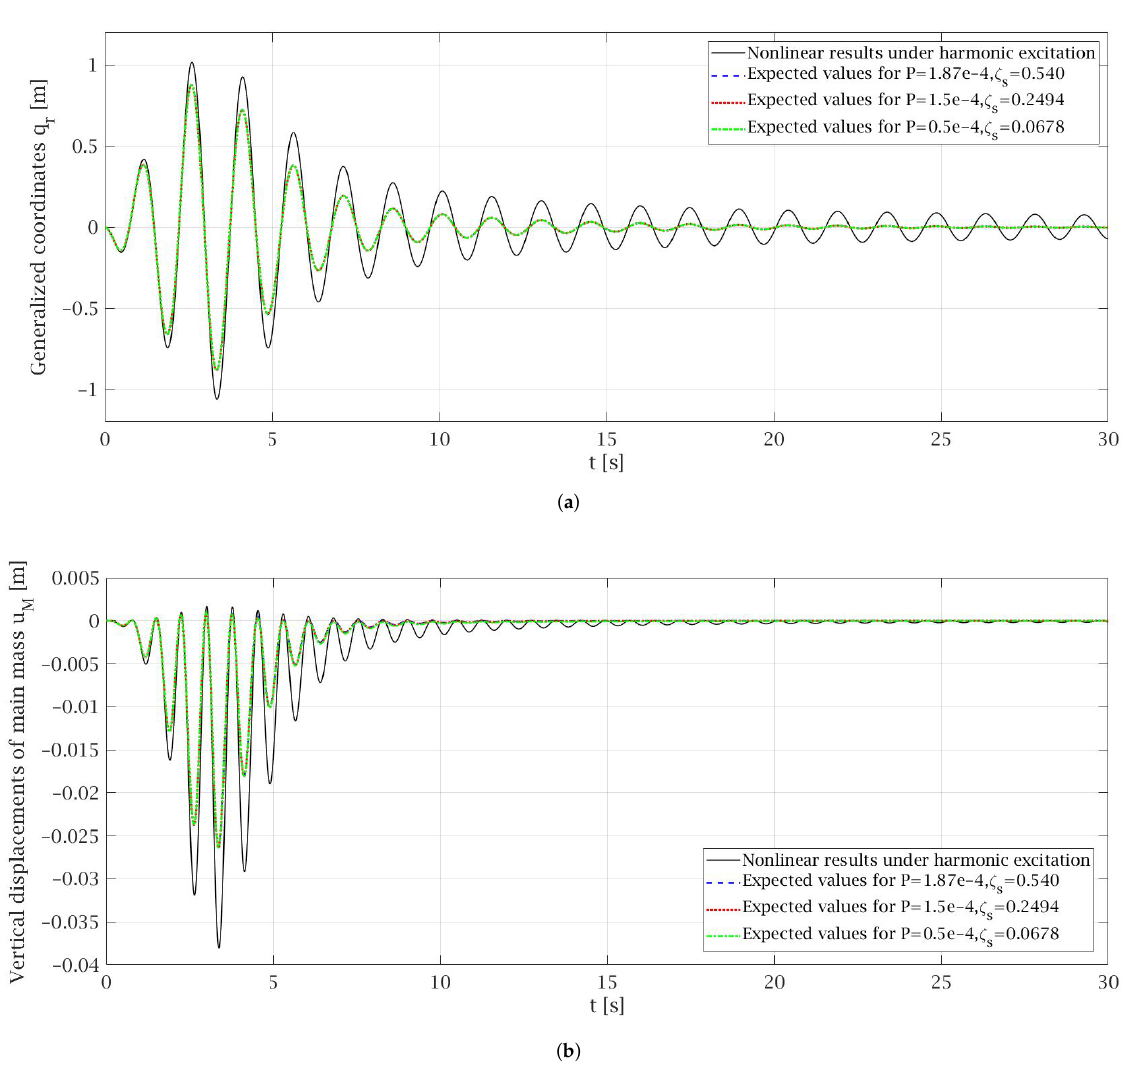
Figure 3. Comparison of the nonlinear results under harmonic excitation with the expected values obtained by equivalent linearization technique: ( a ) Generalized coordinates; ( b ) Vertical displacements of main